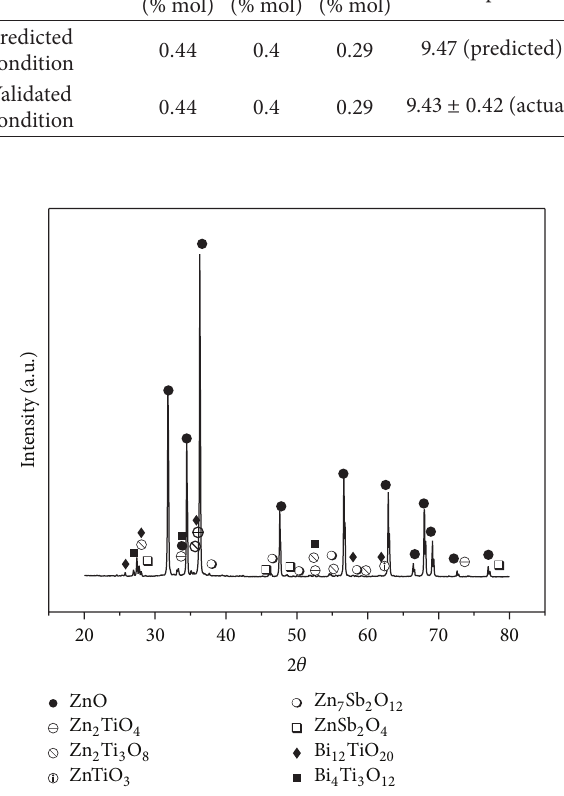
Figure 4: XRD patterns of the ceramic core of ZnO validated varis- tor made at the predicted conditions.